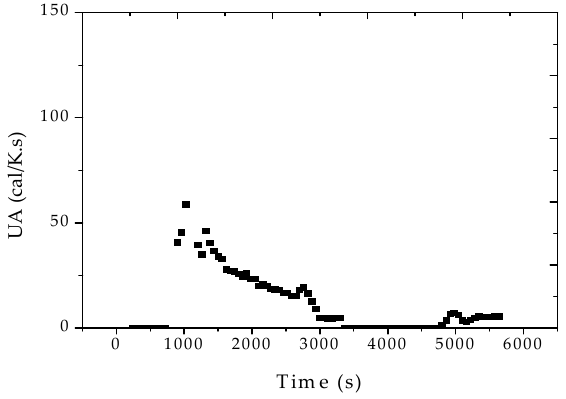
Figure 8. Reconciled UA profiles for reaction R1, considering the formation of fresh monomer droplets.